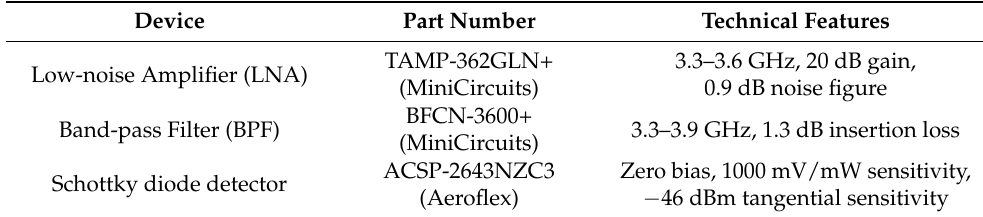
Table 4. COTS components employed in the receiver